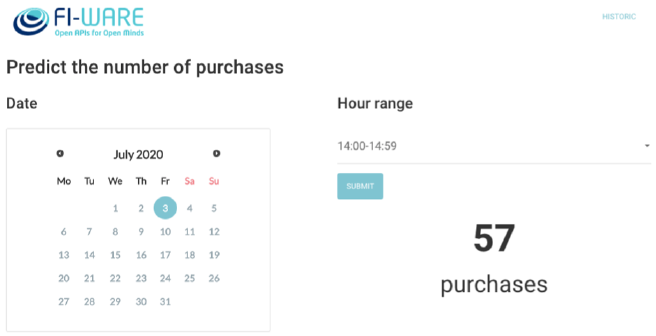
Figure 10. Prediction web application